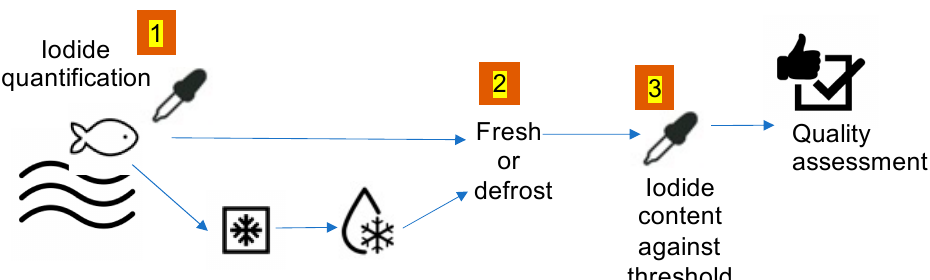
Figure 1. Schematic overview of a typical scenario of application of the method here tested. The multisensory instrument should be used for the evaluation of iodide content in seafood (only when fresh, meaning not defrosted); iodide content could be compared against a selected threshold; a report claiming quality assessment of seafood with respect to iodide content could be generated at the end of the process. The step labelled with numbers 1, 2 and 3 are the ones performed in this work.